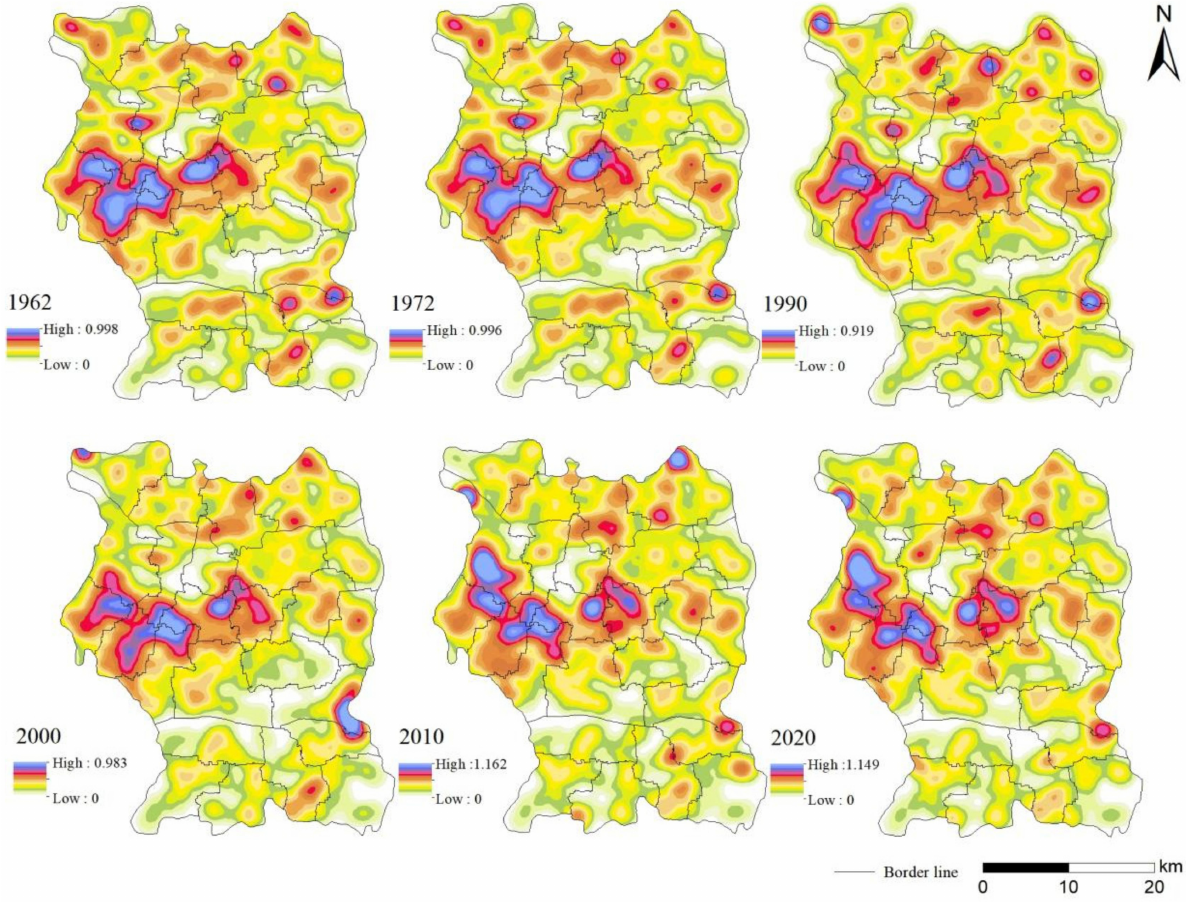
Figure 7. Changes in the kernel density of rural settlements in Dingzhou, China from 1962 to 2020 (Figure created in Arc GIS 10.5 ESRI, https://www.esri.com (accessed on 27 December